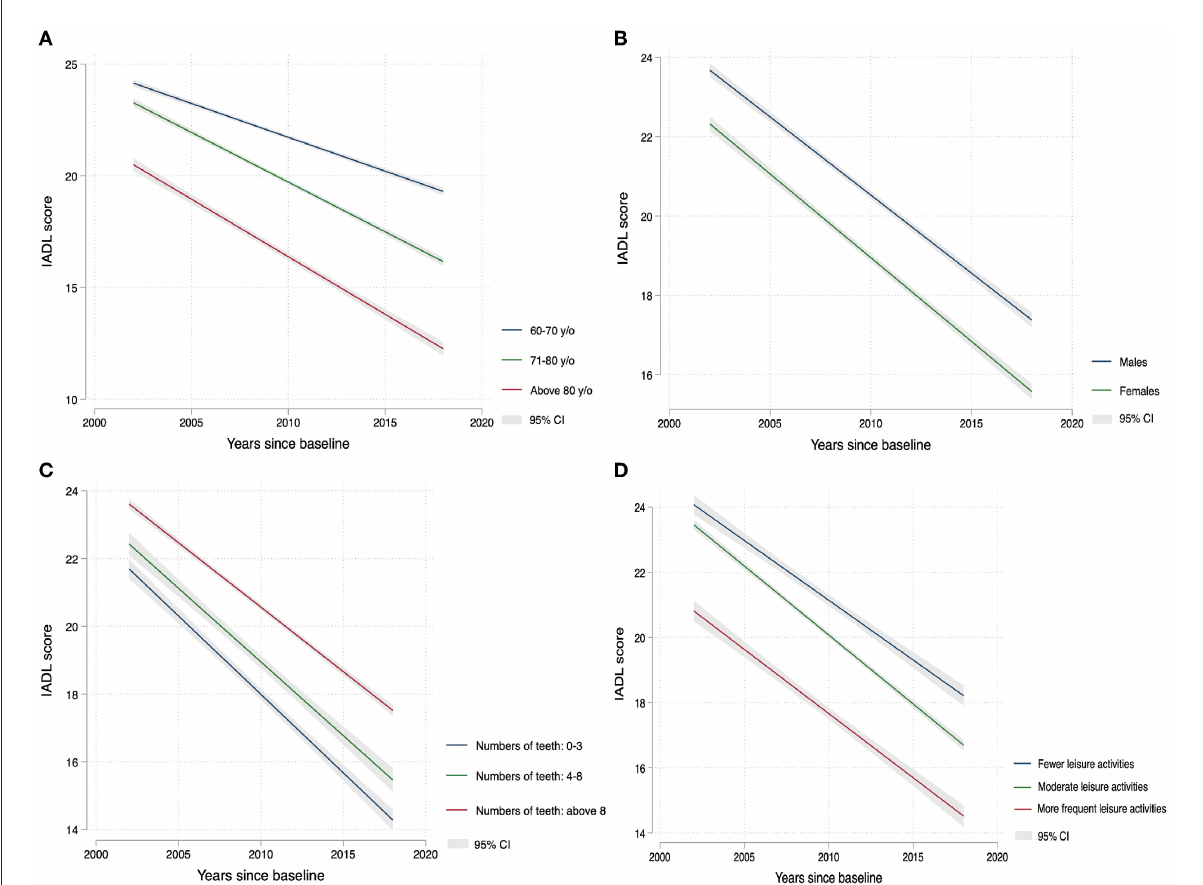
FIGURE5 Linear variation of IADL scores with years of follow-up in different subgroups since the baseline: (A) age (y/o years), (B) gender, (C) the number of teeth, and (D) leisure